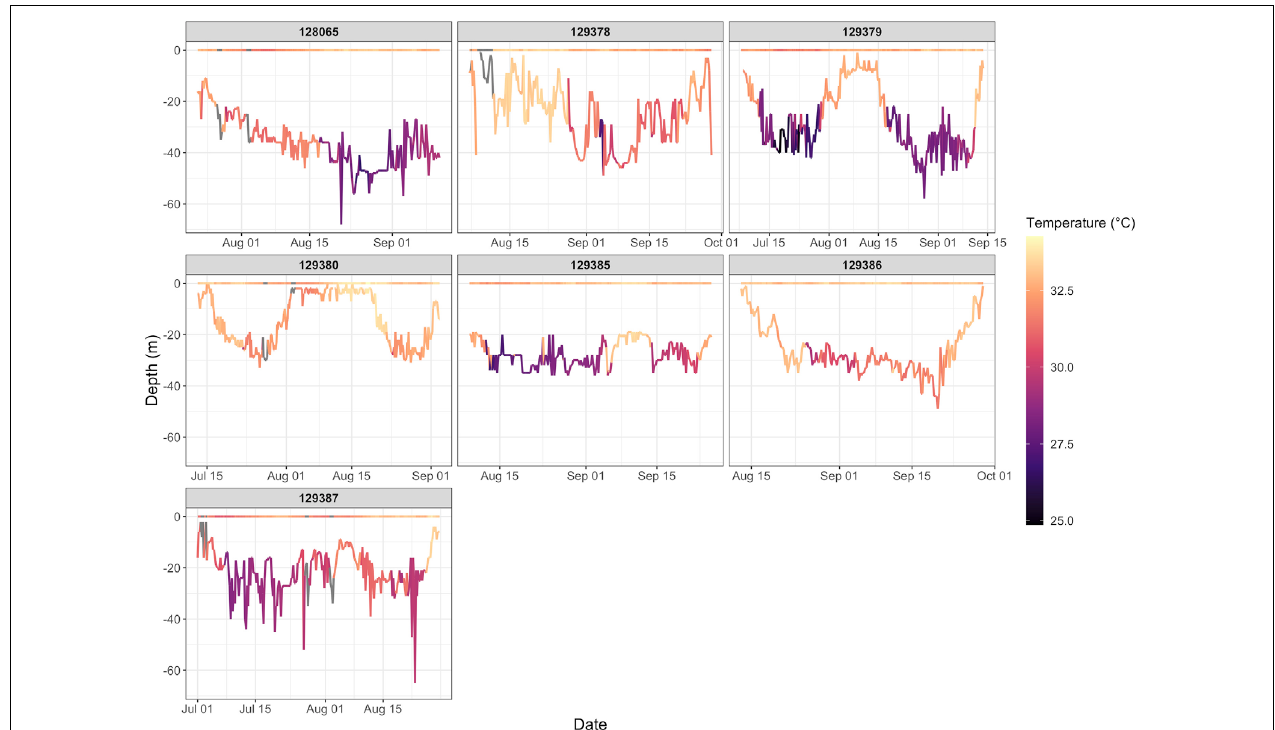
FIGURE 6 | Time series of water temperature shown for all hawksbills that performed summer migrations. Temperatures are shown for both the surface and bathymetric depth at which the turtles were located. Hawksbills 129379, 129380, 129385, and 129387 display two separate migration periods as can be discerned from changes in depth and bottom